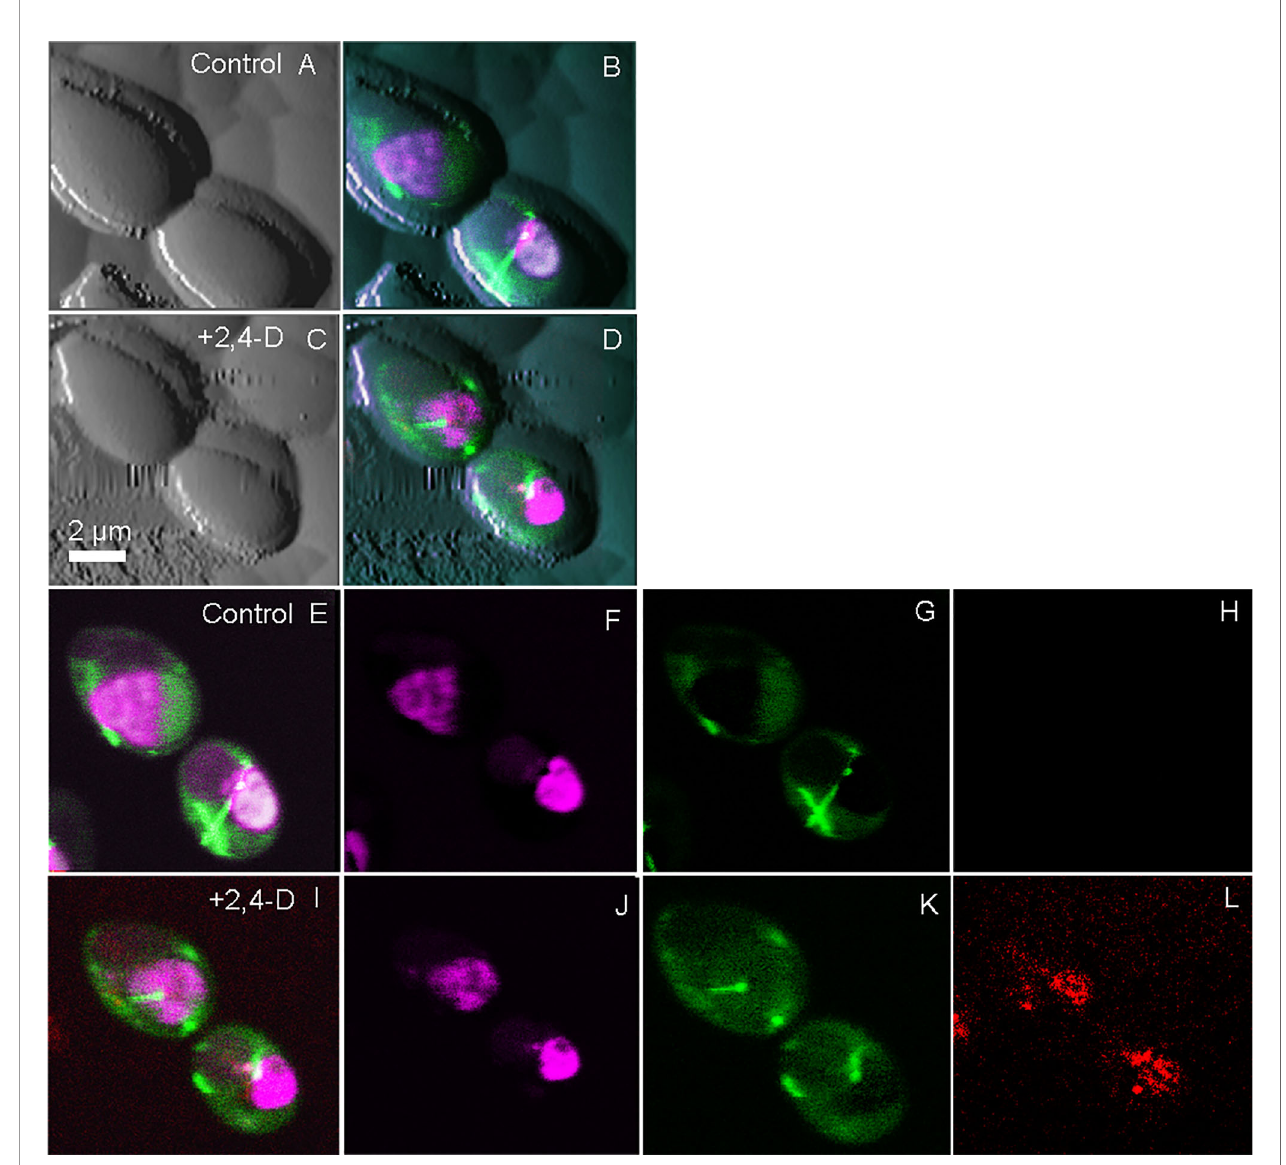
FIGURE 2 | Simultaneously collected correlative AFM-confocal images of the human fungal pathogen C. albicans . Shown is the localization of tubulin2-GFP (green), histone protein B-RFP (purple) and reactive oxygen species (Cell-ROX-deep red, red) following exposure to the herbicide 2,4-D, which chemically induced oxidative stress. Tricolored confocal images are overlaid onto AFM images before and after the induction of ROS (A – D) . Confocal images in the absence of 2,4-D (E – H) are compared with those 5 min after 2,4-D exposure (I – L) showing ROS induction (L) . (E, I) are tricolor merged confocal images; (F, J) shows only RFP, G and K show only GFP and (H, L) show only ROS. The fi gure has been reproduced from Bhat et al. (2018b) with permission from Scienti fi c Reports